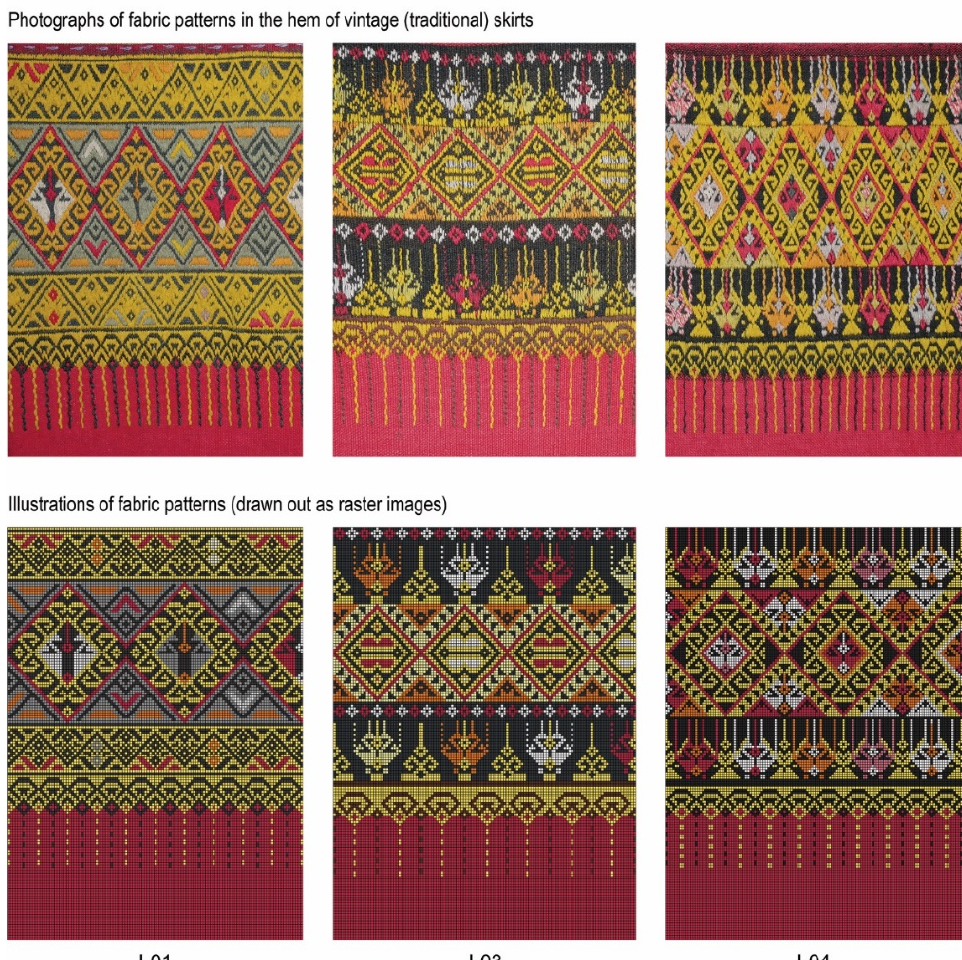
Figure 5. Three pattern sets shown with original photographs and computer-generated images (images from Chudasri).